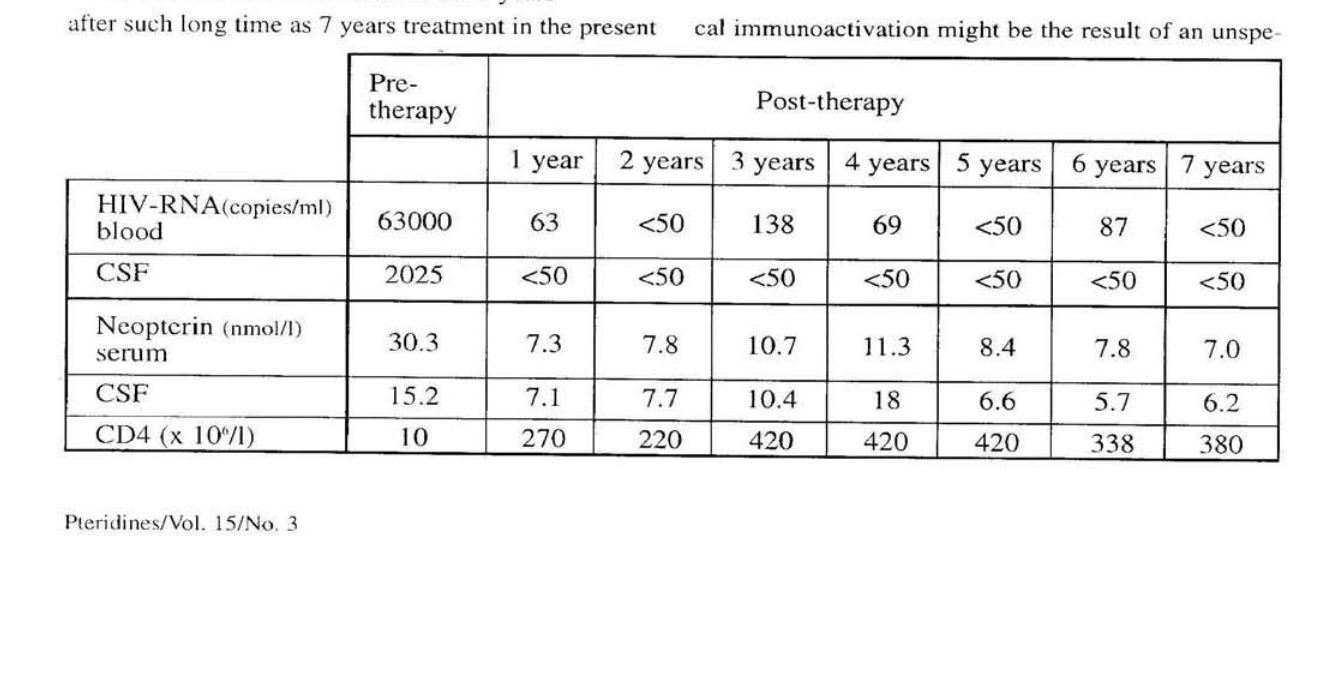
Table 2. Viral load, CD4 cell count and neopterin concentrations in an 48 year old ATOS patient treated with indi- navir, zidovudine and lamivudine for 7